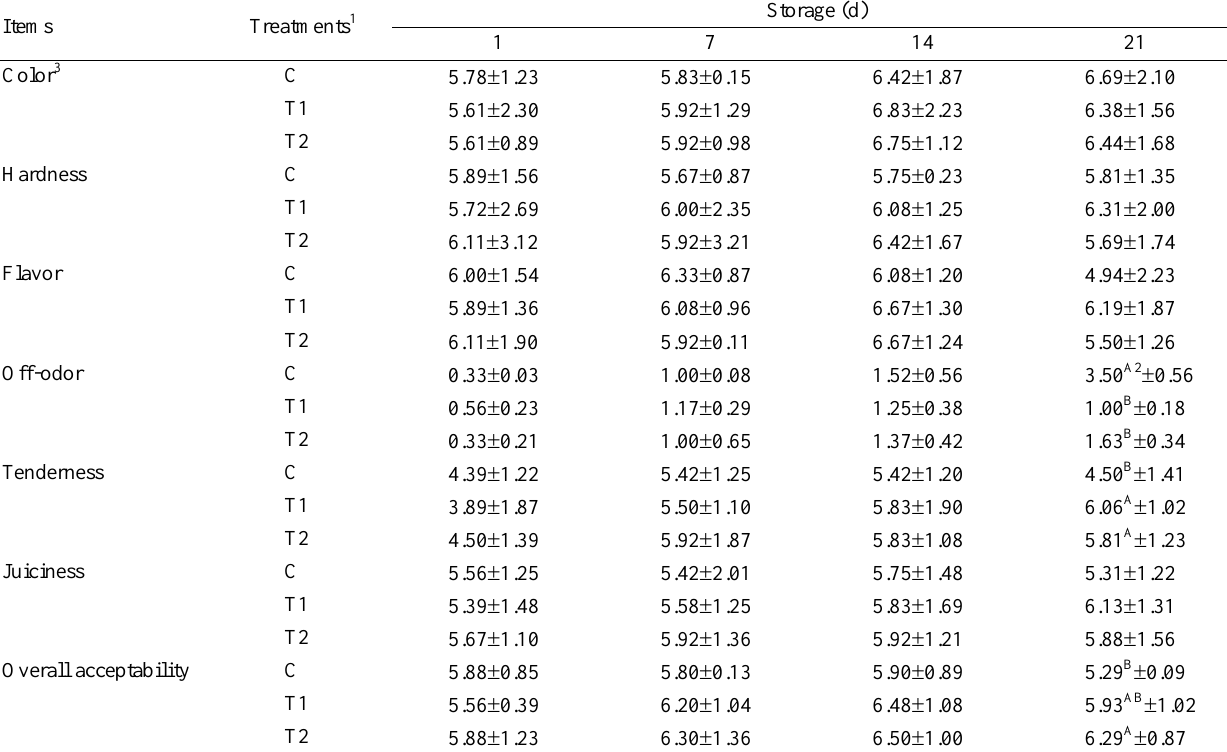
1 C: ziplock bag packaging, T1: vacuum packaging, and T2: MAP (CO 2 /N 2 = 3:7). 2 A-B Means  SD with different superscripts in the same column differ significantly at p<0.05. 3 Color (9 = very good and 1 = very bad), hardness (9 = very hard and 1 = very soft), flavor (9 = very good and 1 = very bad), off-odor (9 = very intense and 1 = very weak), tenderness (9 = very tender and 1 = very tough), juiciness (9 = very juicy and 1 = very dry), and overall acceptability (9 = very good and 1 = very